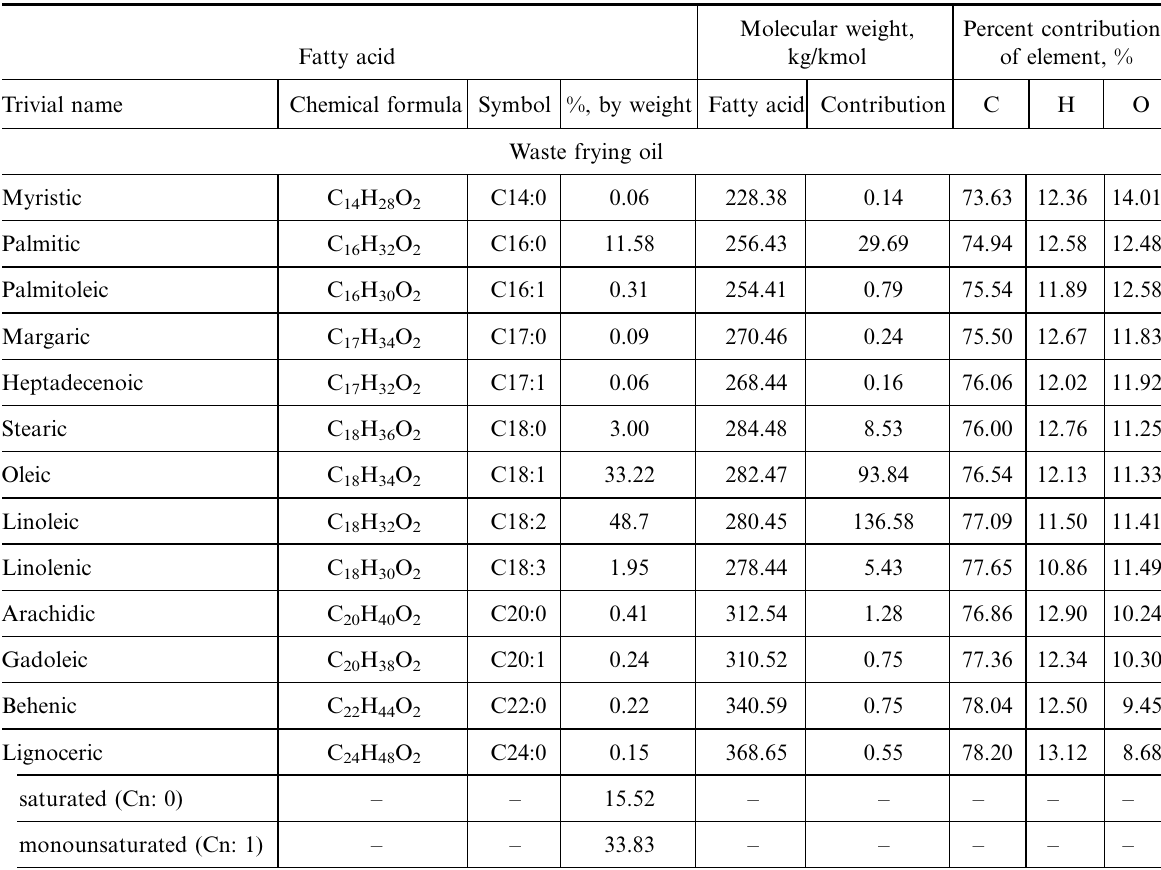
Table 3. Fatty acid composition of WFO and its methyl esters Fatty acid